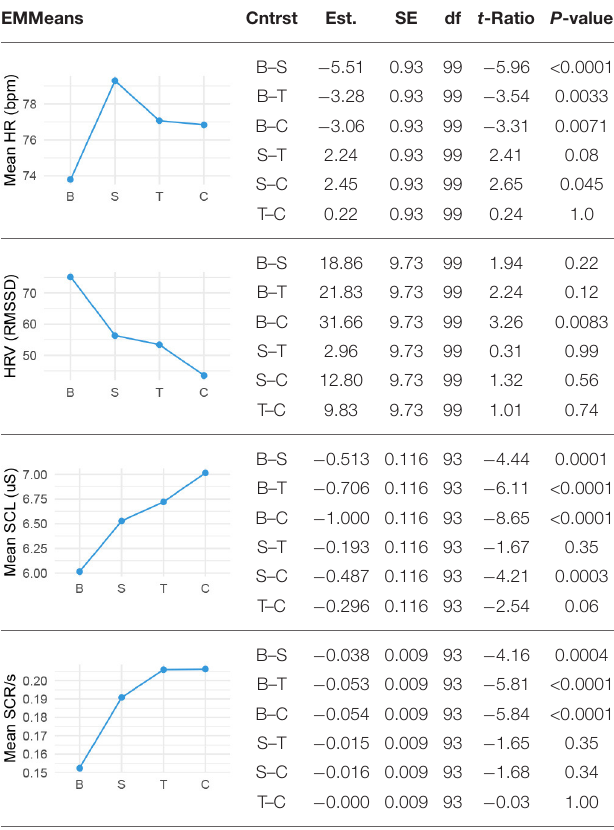
TABLE 2 | Pairwise comparison of physio measures by stage (Tukey adjusted P -values).